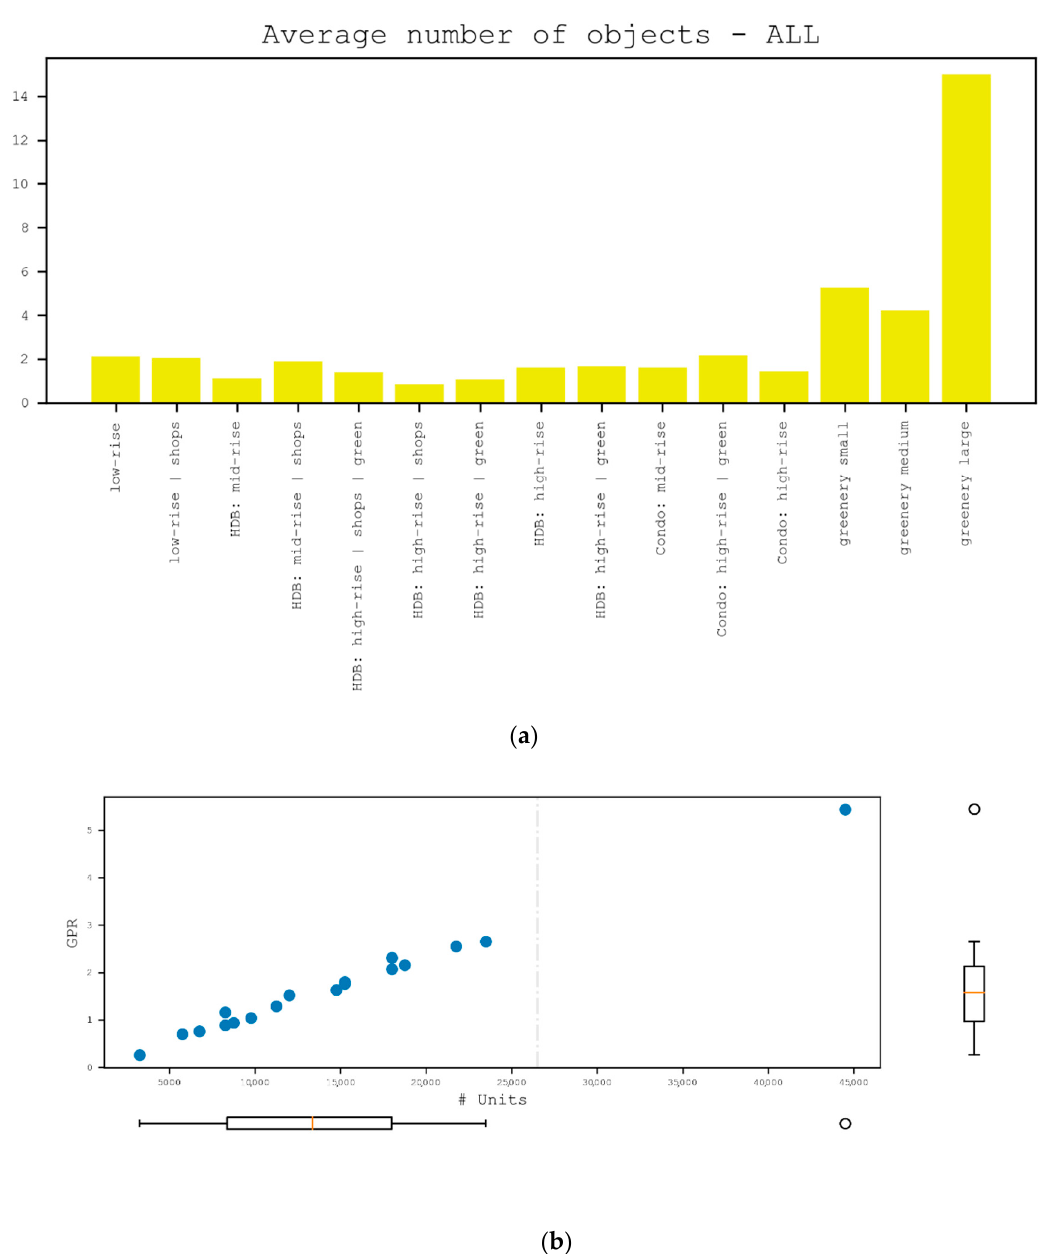
Figure 2. ( a ) Average number of objects placed by participants. ( b ) Gross plot ratio (GPR) and number of units for each submission. The dashed line indicates the desired number of units by the planning authority.